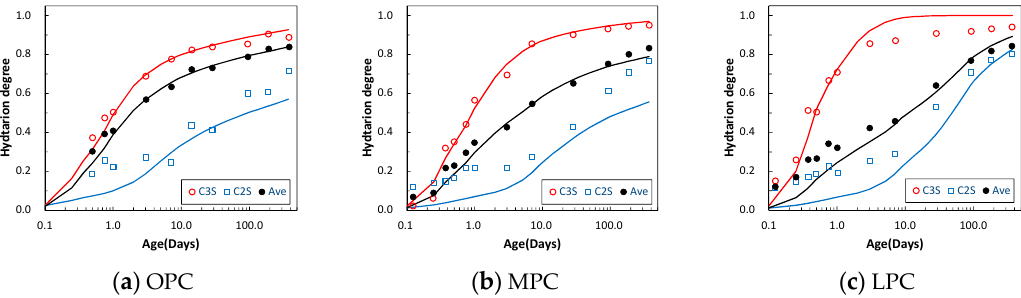
Figure 12. Comparison of degree of hydration among different cement types based on the modified model (W/C40%, Seal-cured at 20 °C) [20]. Table 2. Mineral composition and physical property of the cement used in the adiabatic mass temperature rise tests [23].